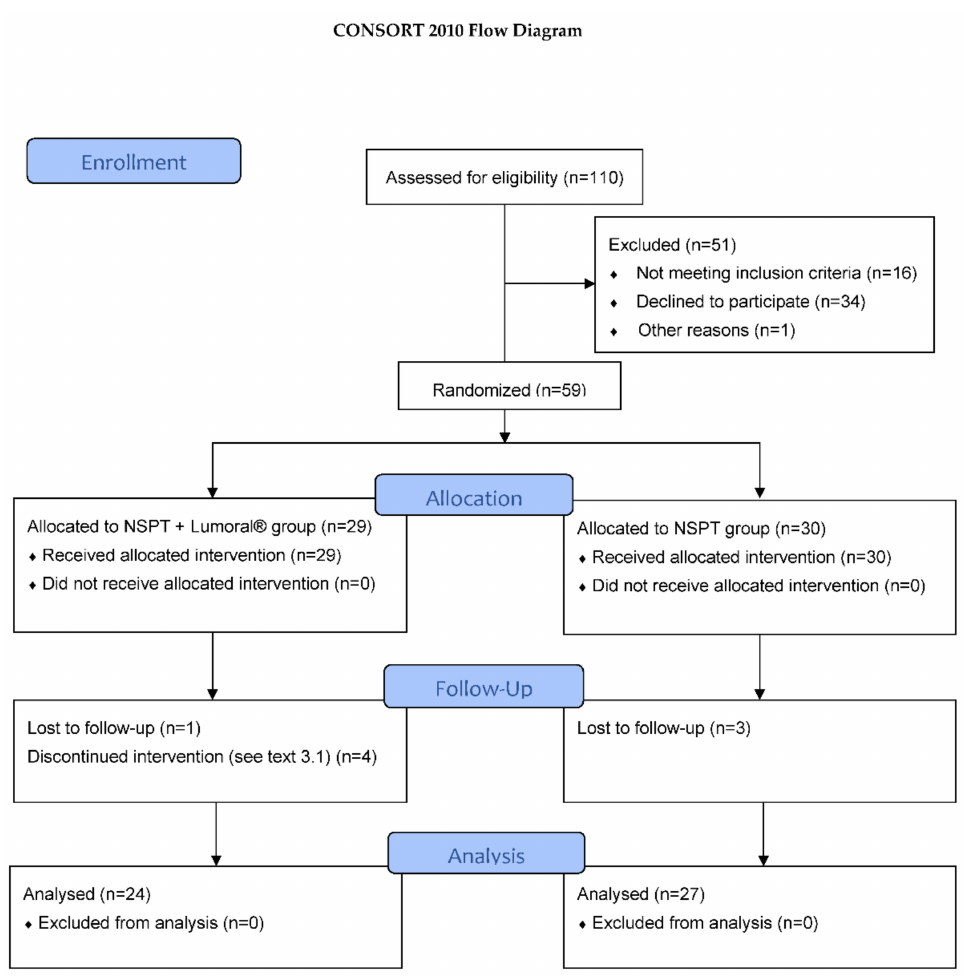
Figure 1. Flow diagram according to the CONSORT